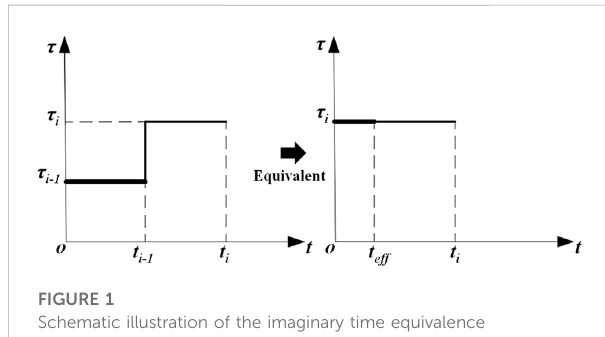
FIGURE 1 Schematic illustration of the imaginary time equivalence